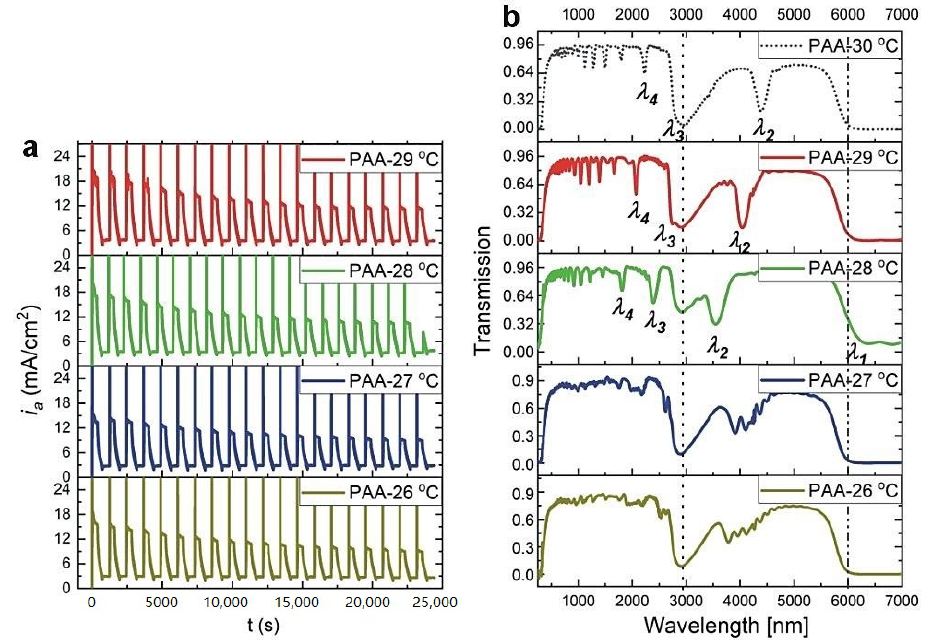
Figure 1. Current density ( i a )—time ( t ) transients ( a ) and corresponding transmittance spectra ( b ) of PAA-based photonic structures anodized at the temperature range 29–26 ◦ C with the following parameters: U H = 50 V, t H = 360 s, U L = 20 V, t L = 480 s, U H - > U L rate = 0.078 V / s, 20 cycles (the transmission spectrum for the PAA-30 ◦ C sample is from ref. [27]).